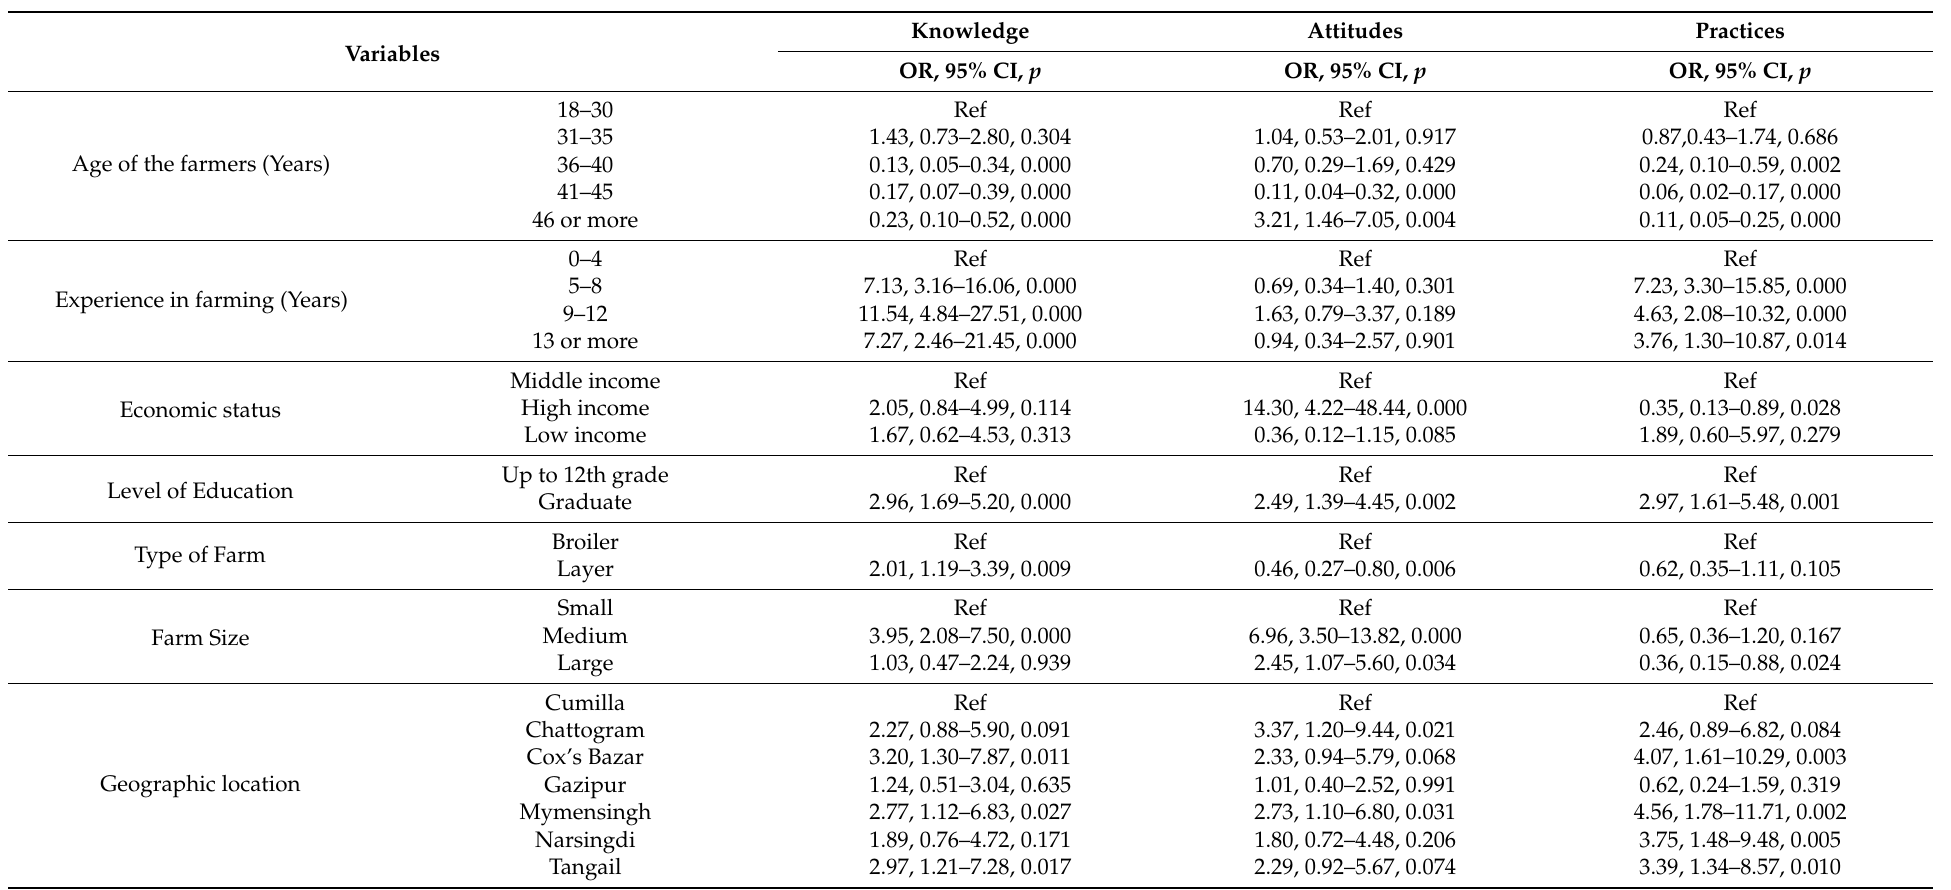
Table 6. Adjusted logistic regression analysis of the factors associated with respondents’ knowledge, attitudes, and practices of AMU and